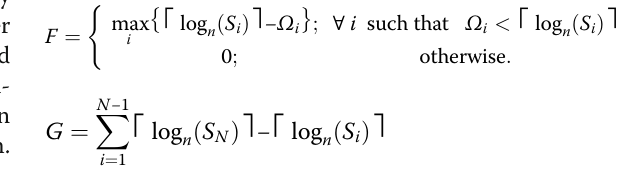
Table 2 Percentage of constants with improved lower bounds Word